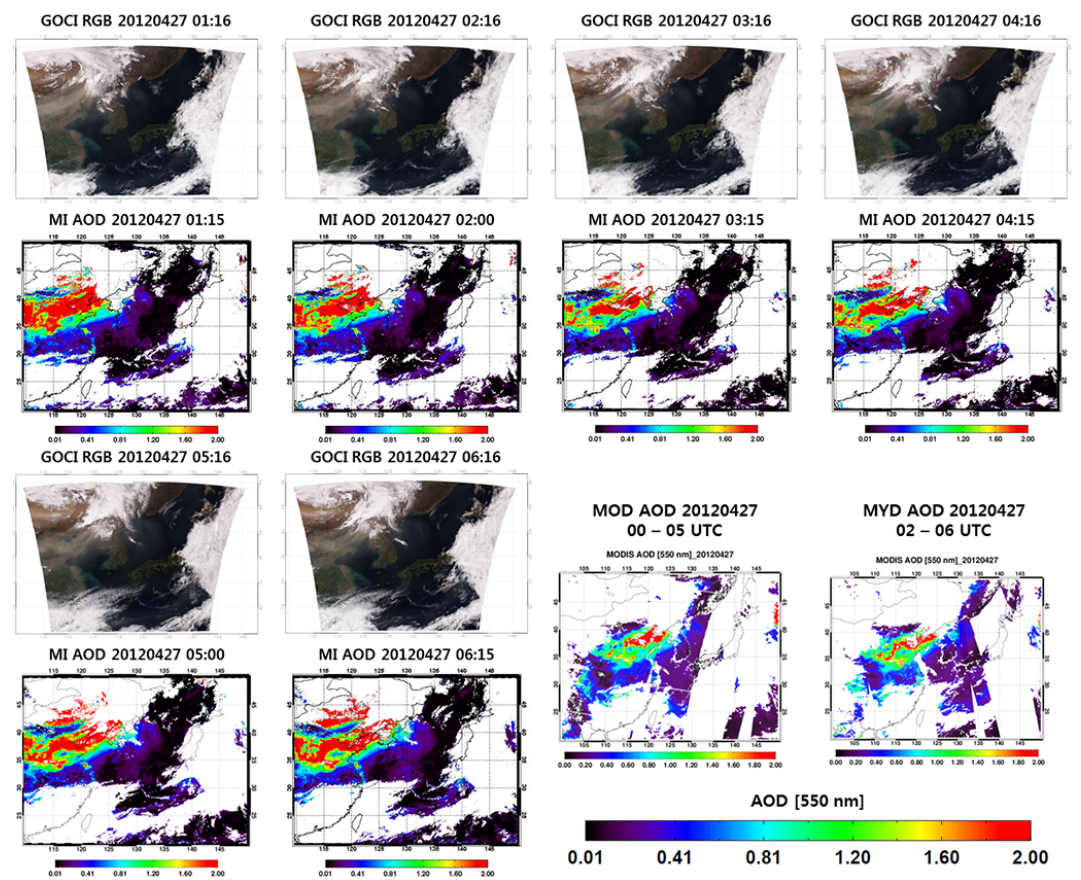
Figure 8. Red, green, and blue images obtained from GOCI measurements and examples of retrieved AOD from MI measurements on 27 April 2012. Two panels on the bottom right-hand side show the MODIS AOD product obtained from TERRA (MOD04) and AQUA (MYD04) measurements. The AOD ranges between 0 and 2 in these